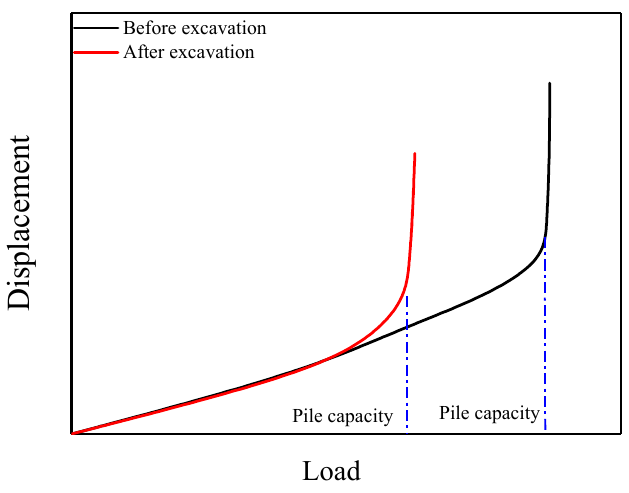
Figure 13. Schematic of the determination of the pile uplift capacity.